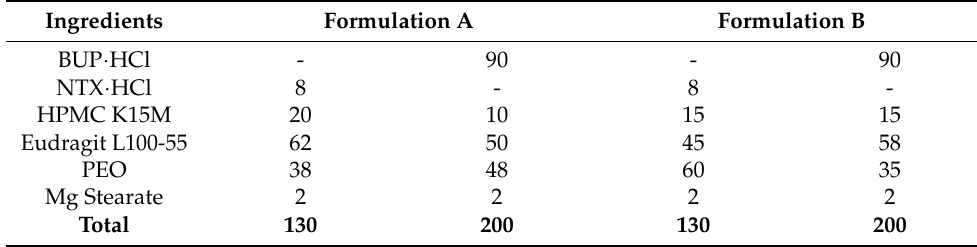
Table 1. The composition of BUP · HCl and NTX · HCl tablet formulation